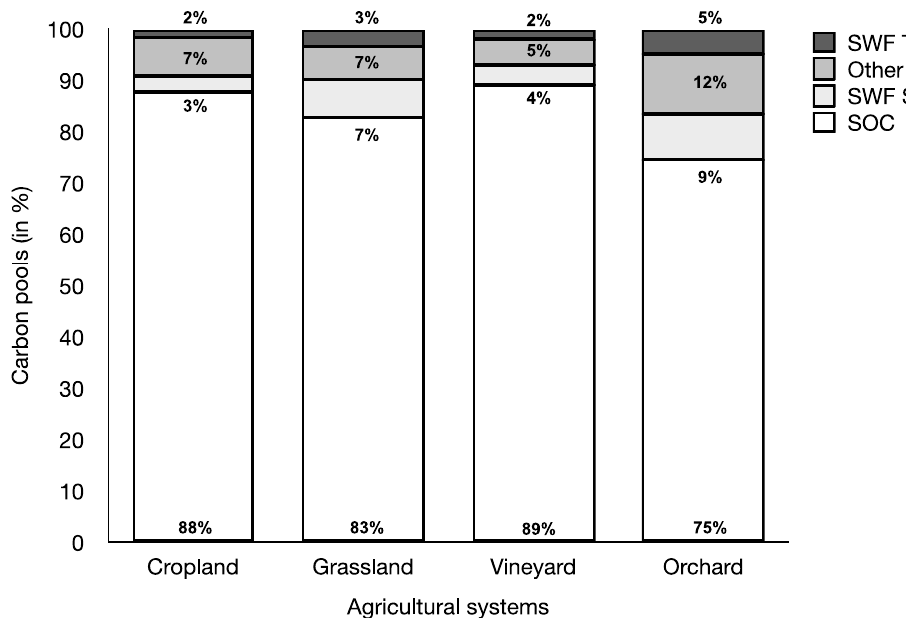
Figure 5. Relative contribution of the components to total carbon pools in four agricultural systems. ‘Other TBC’ refers to annual crop TBC in arable systems, herbaceous TBC in grassland systems, and woody (not SWF) TBC in vineyard and orchard systems.